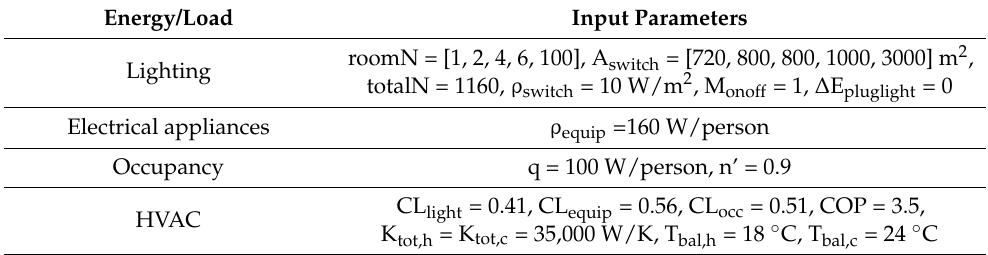
Table 2. Basic input parameters used in